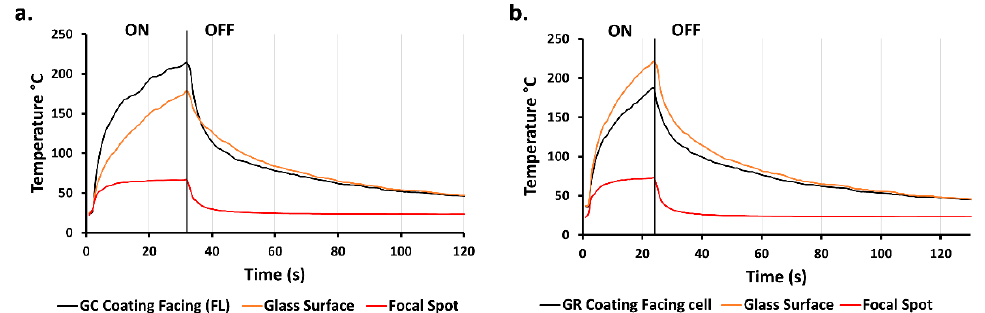
Figure 4. GC 6.3 sample ( a ) facing the source of solar irradiance and ( b ) facing the polycrystalline cell. The GC 2.2 demonstrated a relatively low-temperature difference, in contrast to GC 6.3 . source of the solar irradiance by 15%, as in Figure 5a. In contrast, the temperature on the GC surface was lower than the surface glass for the GC facing the solar cell by only 2.2%, as in Figure